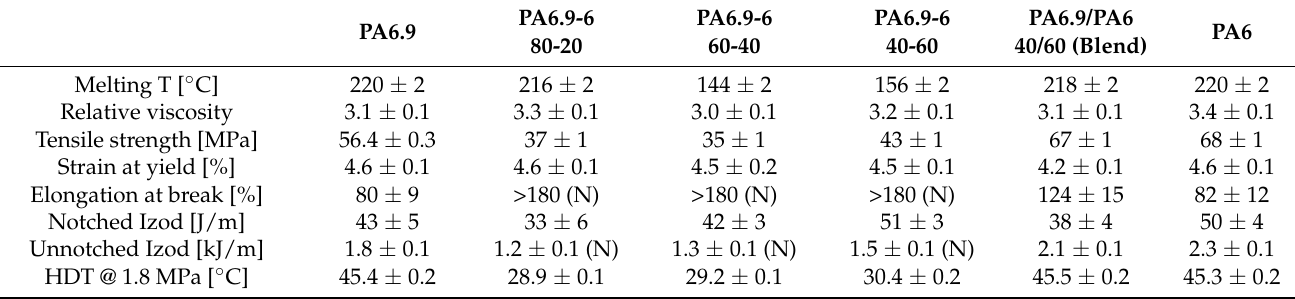
Table 1. Properties of pure polymers, copolymers (80-20, 60-40, 40-60) and blend (40-60). PA6.9